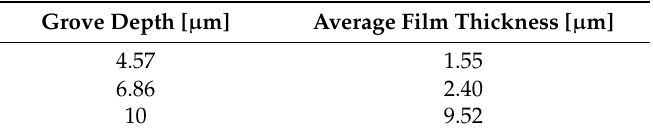
Table 1. Measured average liquid film thicknesses on the polyimde film obtained with different profile rod grove depths.